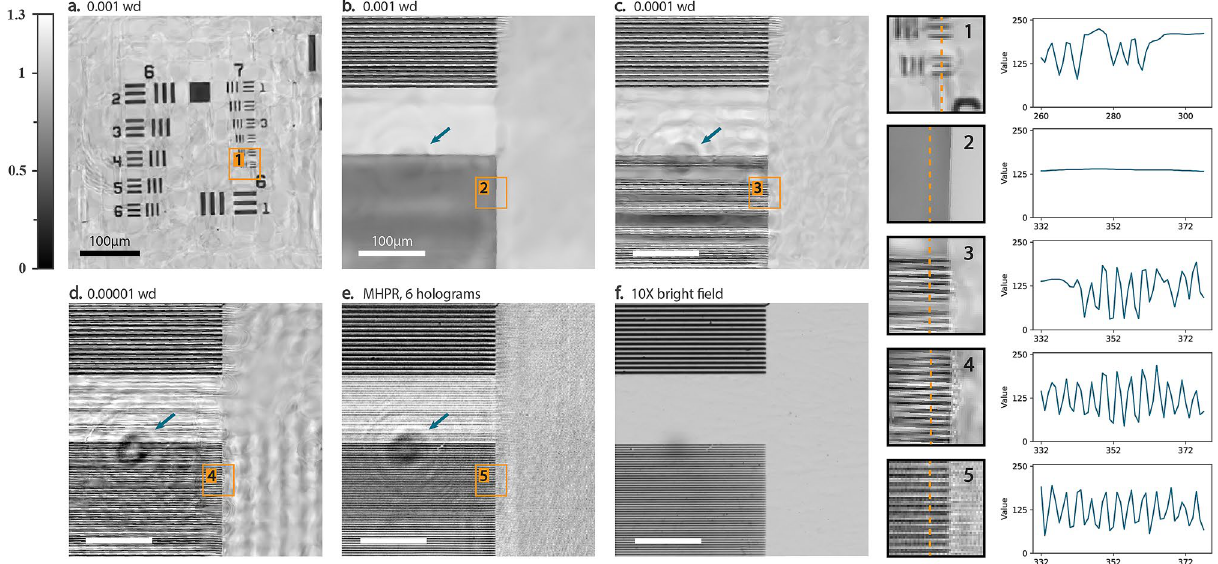
Figure 6. ( a ) the reconstructed amplitude of a standard resolution target (228 lp/mm for the finest details). ( b , c , d ) The amplitude images recovered from the transmissive grating (125 and 250 lp/mm) by DCOD with 3 5 weight decay ranging from 10 − to 10 − . ( e ) The reconstructed amplitude image obtained by multi-height phase recovery method using 6 holograms. ( f ) The microscopic image captured from the same field of view using a 10× 0.2 N.A. objective